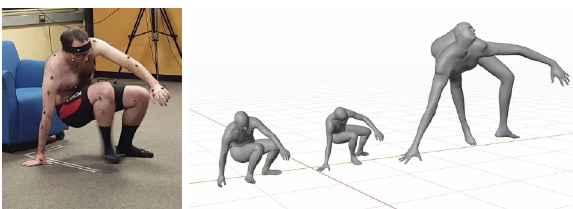
Fig. 6 Left: original frame. Right: estimated body model meshes: (left) ground truth model, (middle) nearly accurate estimate from our approach, (right) SMPLify-X’s estimate has a distorted body